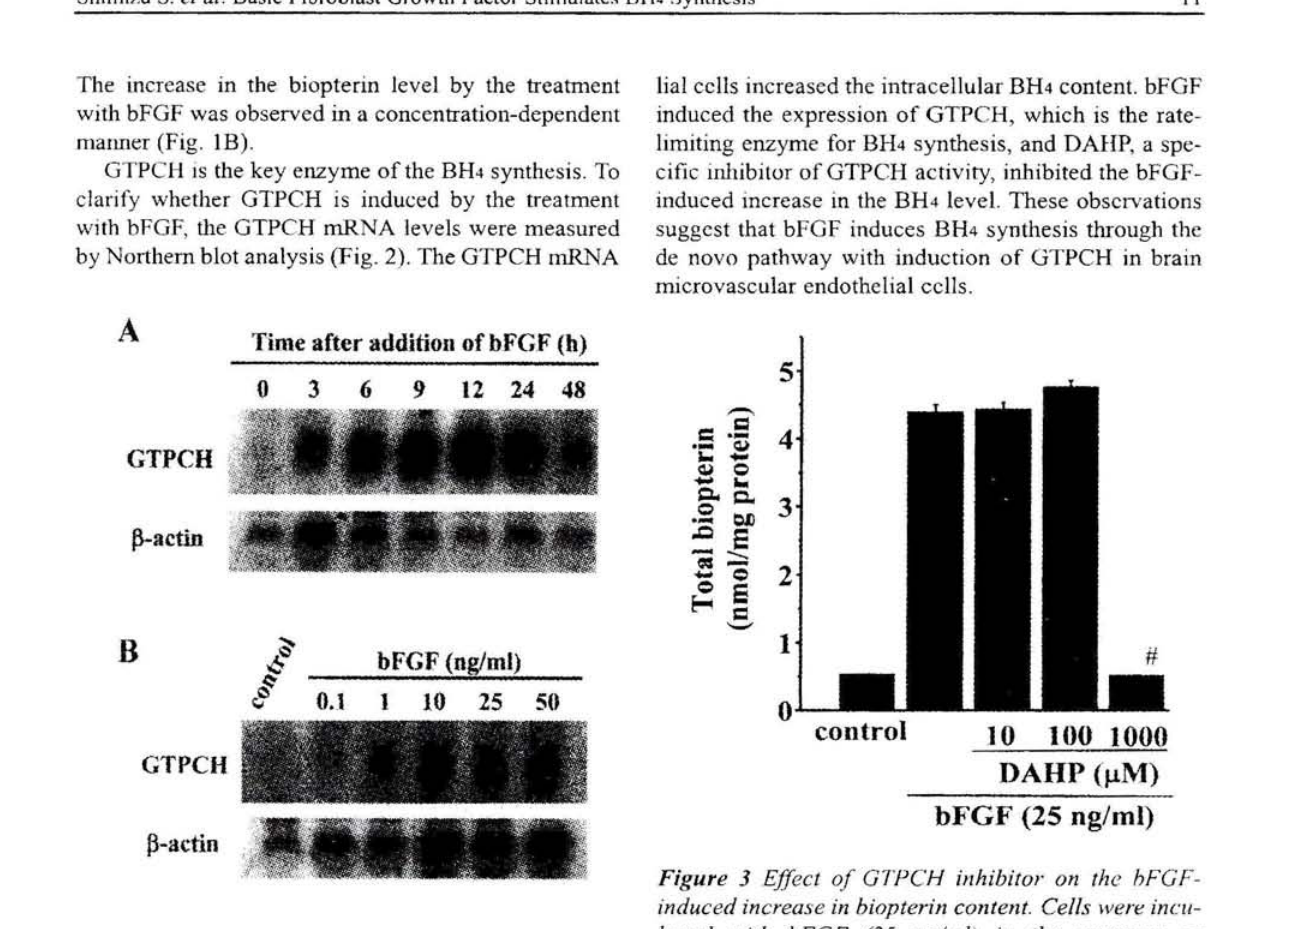
Figure 2 The induction of the expression of GTPCH mRNA by bFGF treatment. A: Cells were incubated •Mth bFGF (25 ng/ml) for various periods, and then total RNA was extracted from the cells. B: Cells were incubated with bFGF (0.1-50 ng/ml) for 9 h, and then total RNA was extracted from the cells. After elec- trophoresis of 20 ßg of total RNA per sample and iransfer to a nylon membrane,